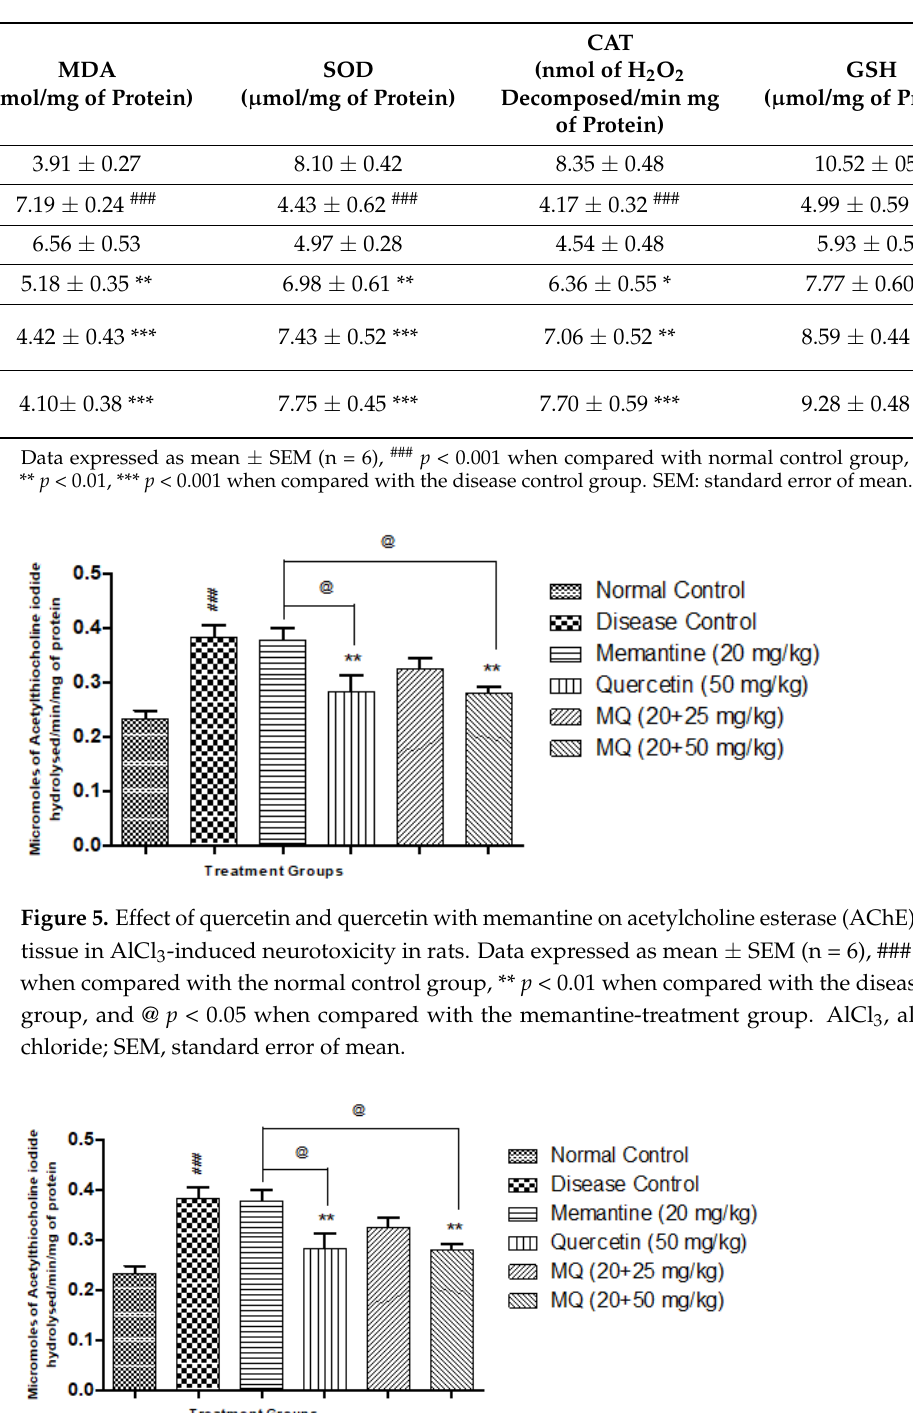
Table 2. Effect of quercetin and quercetin with memantine treatment on oxidative stress parameters in the hippocampus.